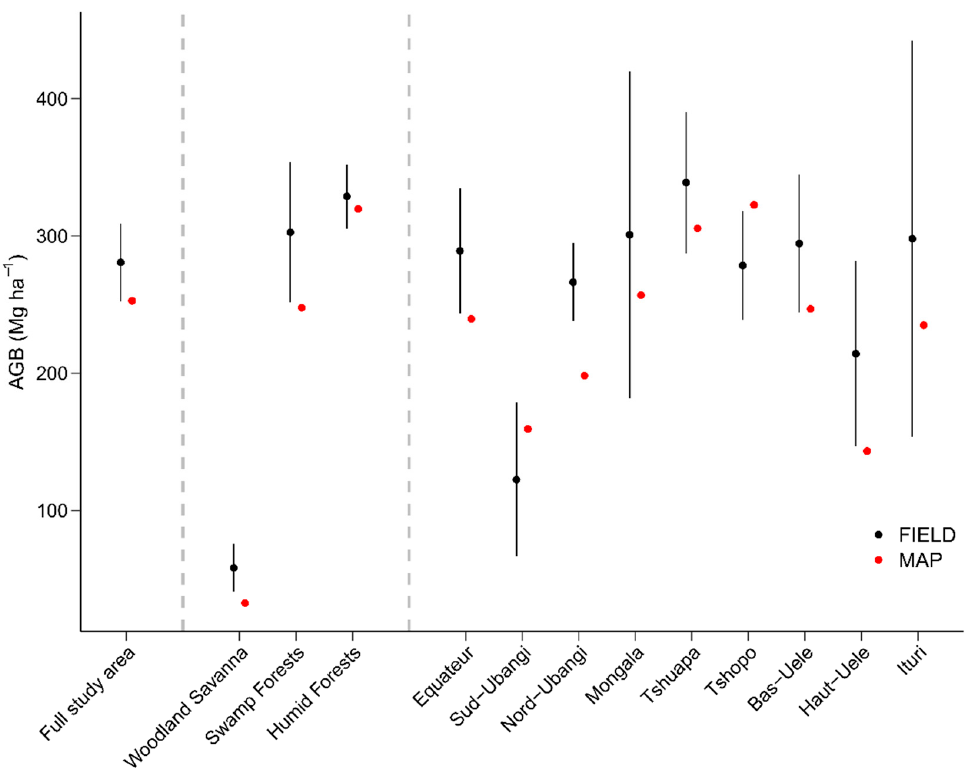
Figure 6. Mean biomass estimates at study area, landcover class and provincial scales. Estimates from field data are bounded by a 95% confidence interval. All confidence intervals include errors arising from sampling, missing inventory data, WD, H and the allometric model.